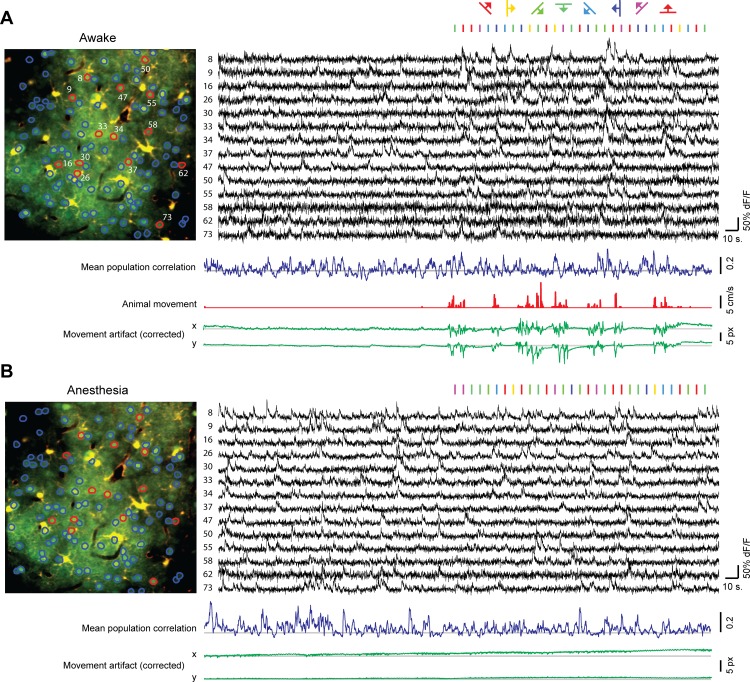
Imaging spontaneous and evoked calcium activity of the same identified neurons during the awake and anesthetized state.(A) Image of detected (red and blue encircled) neurons and astrocytes in the awake mouse. Black traces (right) are the neuropil contamination-corrected ΔF/F calcium time series of the red-encircled neurons in the image (left). Vertical lines above the calcium time series indicate times when visual stimuli (gratings) were presented, each movement direction in a different color. The blue trace represents the evolution of the mean correlation between all pairs of displayed neurons (calculated over a sliding two-second window). The red trace shows animal movement, measured from treadmill motion. The green traces indicate the (corrected) horizontal (x) and vertical (y) image displacement, which was highly correlated with animal motion. Respective scale bars are located on the right, grey horizontal lines represent the horizontal zero axis. (B) Idem as in A, but recorded 45 to 70 minutes later under anesthesia (1.0% isoflurane in O2). Note the difference in scaling of the ΔF/F signals with (A).